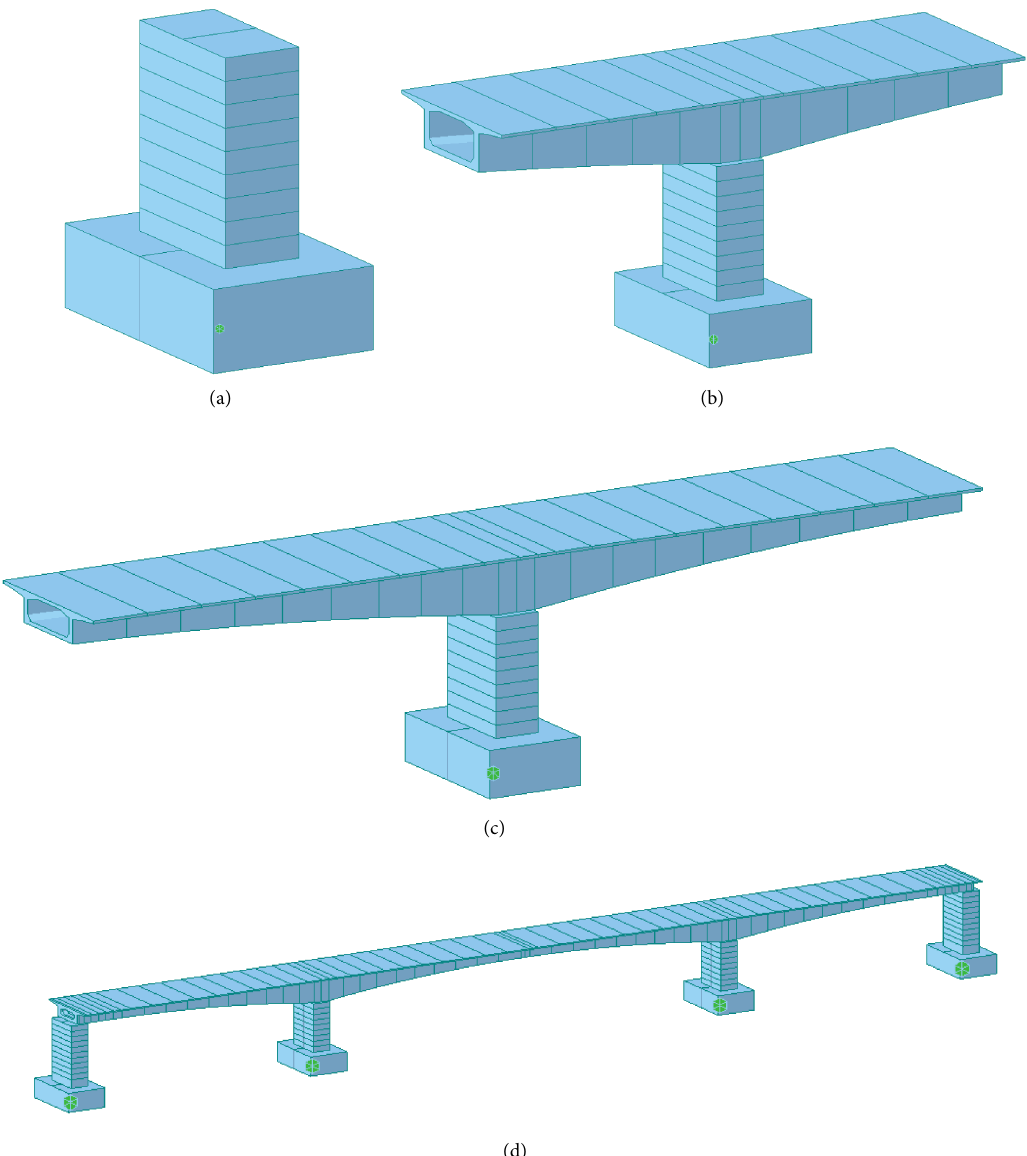
Figure 4: Researched construction stages for the case study bridge. (a) Substructure construction stage. (b) Middle cantilever construction stage. (c) Long cantilever construction stage. (d) Middle span closure construction stage and bridge completion construction